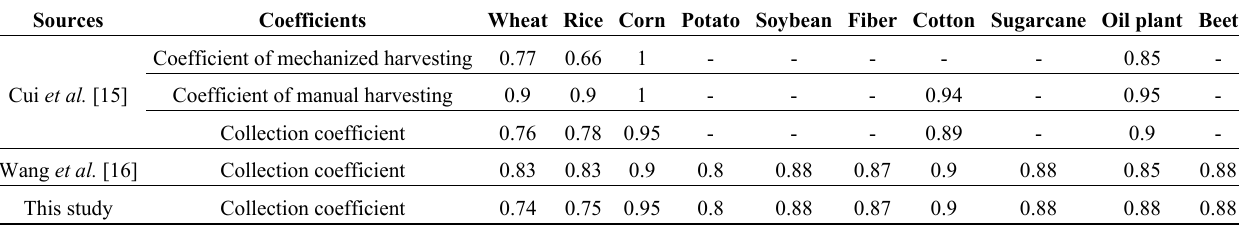
Table 2. Collection coefficients of main crop